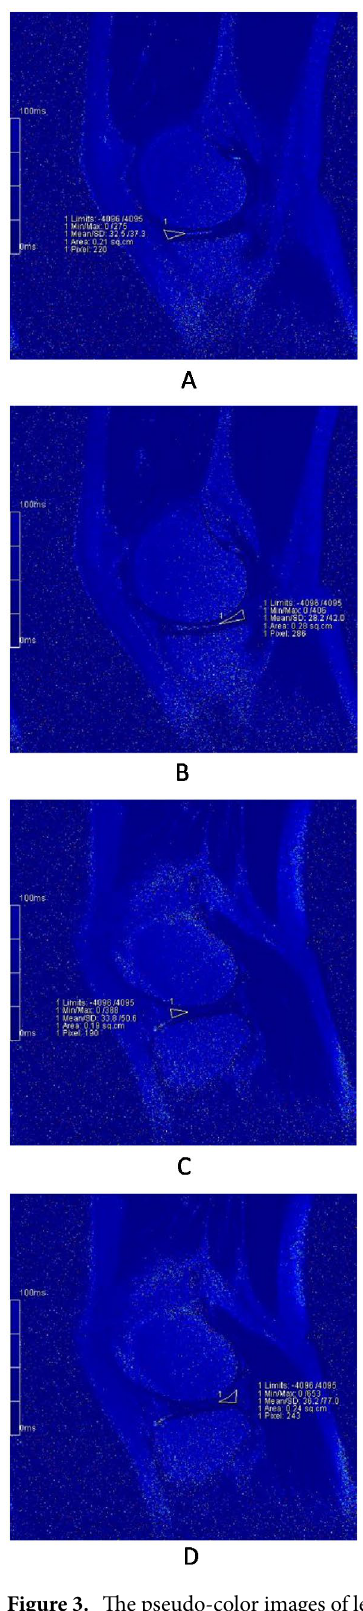
Figure 3. The pseudo-color images of left knee of a 28-year-old female at three timings. ( A )–( D ) are the images before the match. Fig. A/B/C/D are the images MMAH/MMPH/LMAH/LMPH respectively. The T2 values accordingly were 32.5 ms, 28.2 ms, 33.8 ms, 36.2 ms,